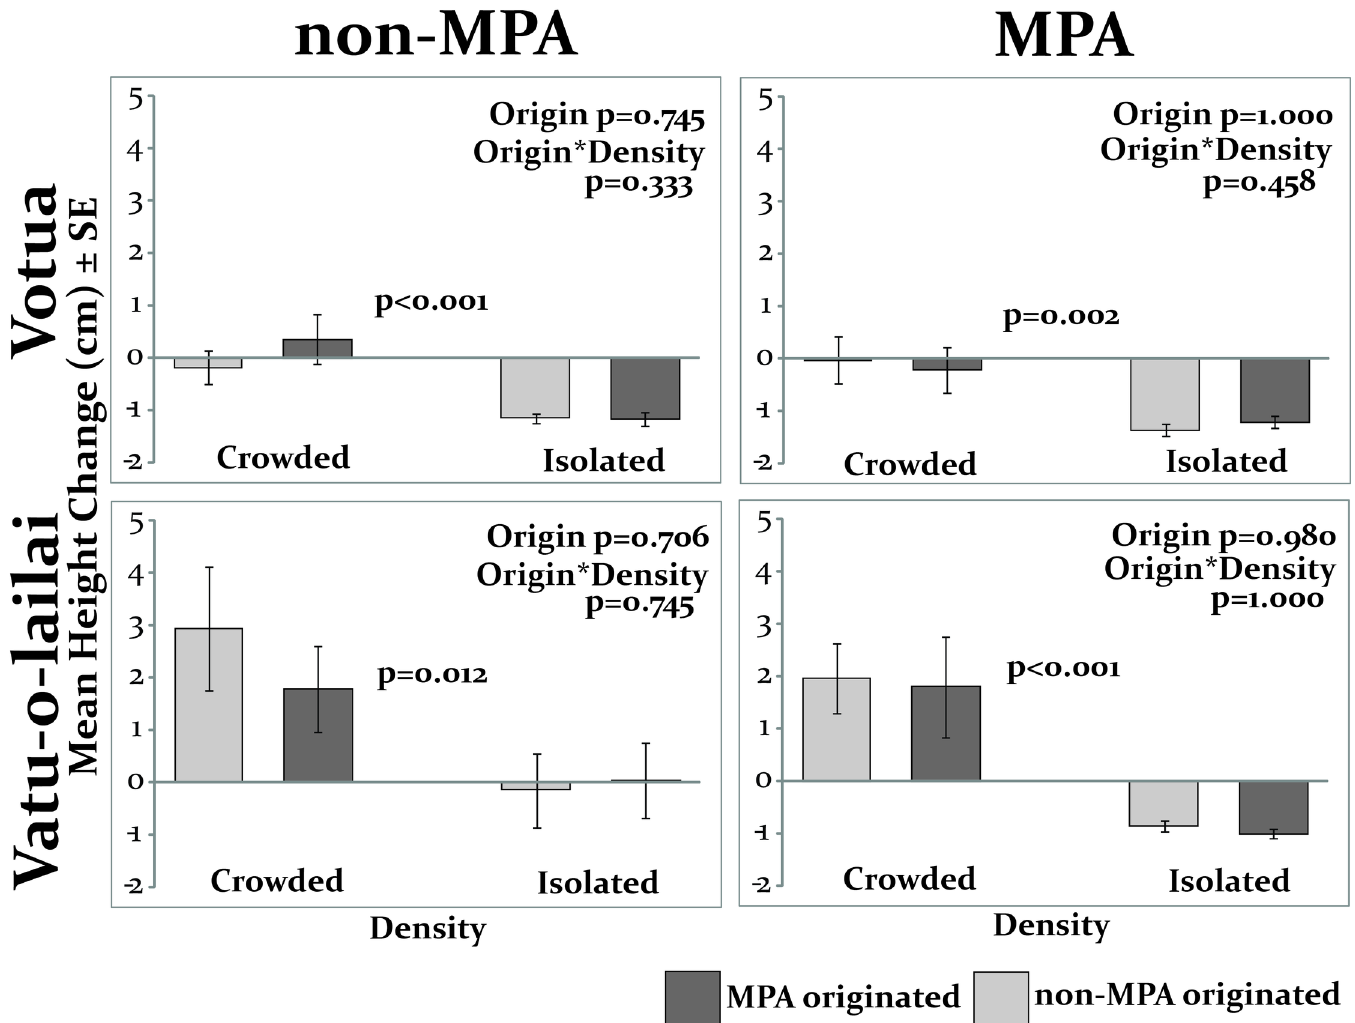
Fig 6. Growth of recruit-sized ramets growing in crowded or isolated densities in the MPA and non-MPA of both villages (N = 15). Initial height was subtracted from final height for all ramets, meaning those that died were included as negative values; statistical analyses were by Permutation